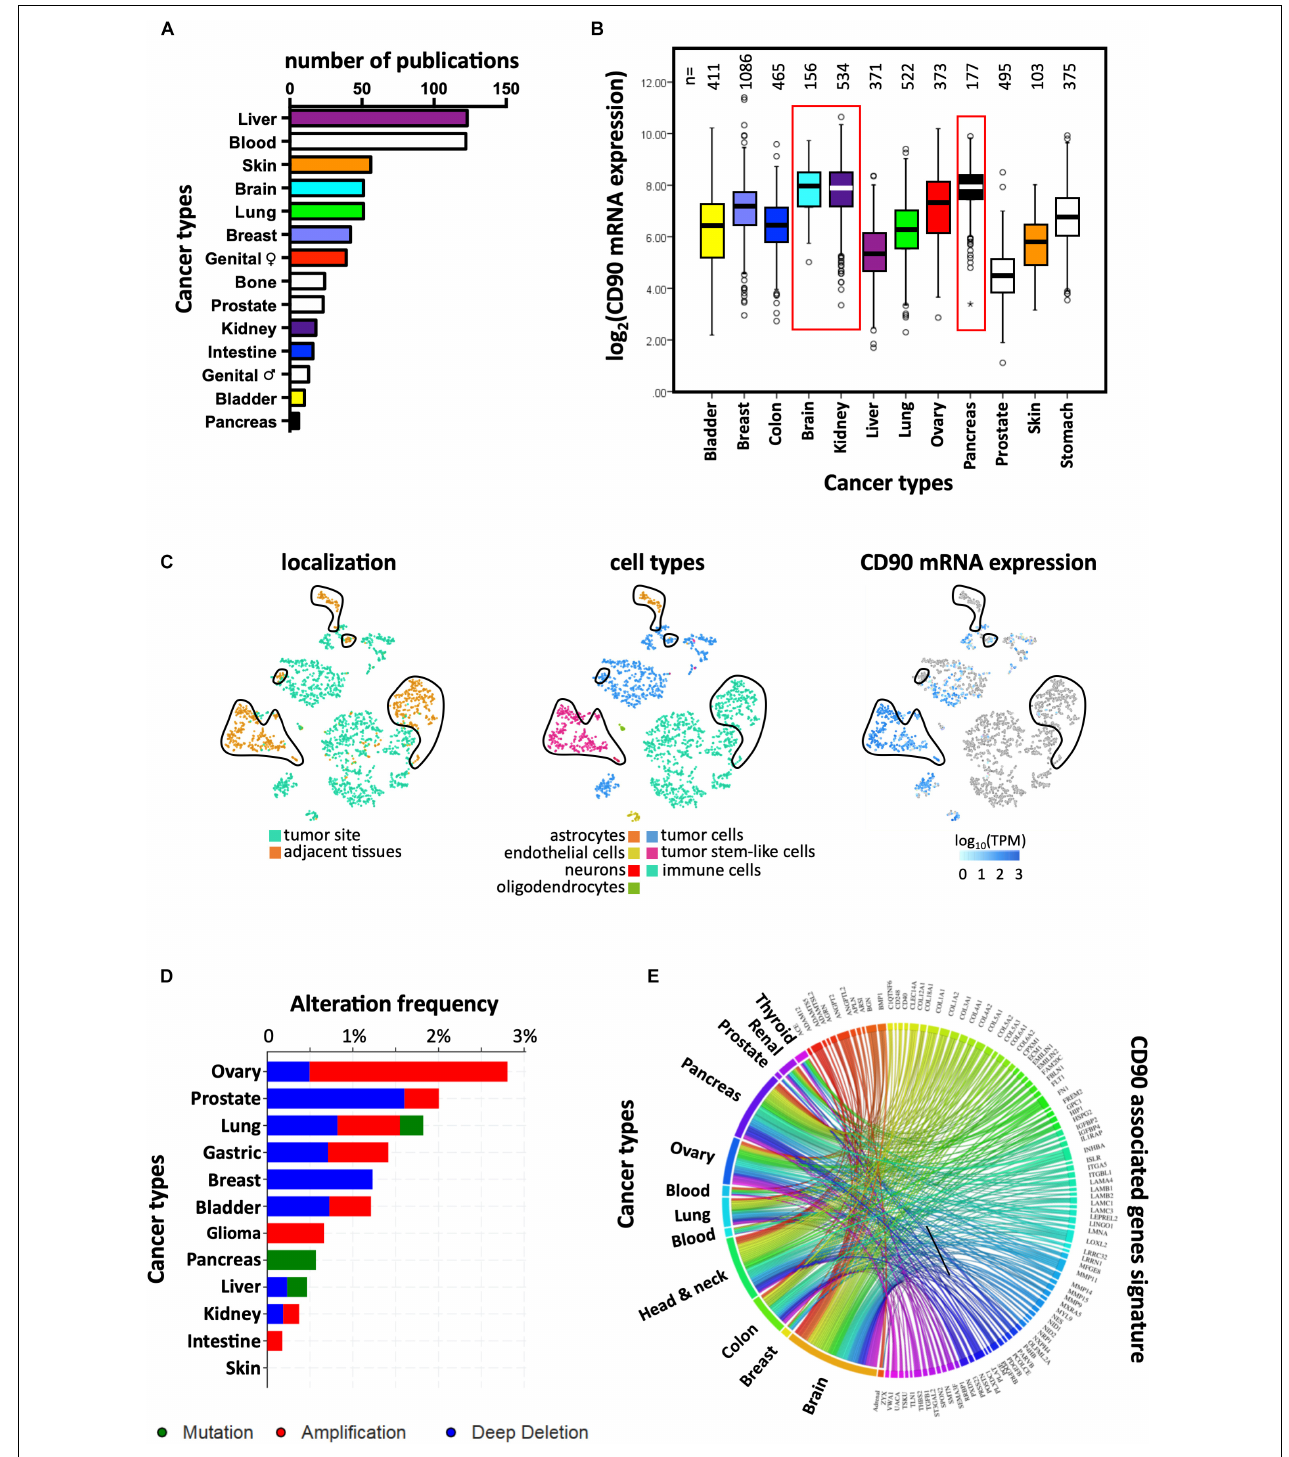
FIGURE 2 | Links between CD90 and cancers. (A) Articles reporting CD90 in various human cancer types were collected using Pubmed and their distribution per cancer type is presented. (B) CD90 mRNA expression was analyzed among the various cancer types using the TCGA resource. The corresponding number of tumor specimens tested are indicated on the top of the graph. (C) CD90 mRNA expression was analyzed in the single cell RNA sequencing dataset from GBM specimens (Darmanis et al., 2017) using the EMBL-EBI Single Cell Expression Atlas (https://www.ebi.ac.uk/gxa/sc/home). Cell localization and cell types are also represented. (D) Frequency of CD90 gene alterations including mutations, gene amplification and deletion was analyzed among the different cancer types. (E) CD90 associated gene signature obtained from GBM specimens (Avril et al., 2017a) was tested in others cancer types using CancerMA tool (Feichtinger et al., 2012).